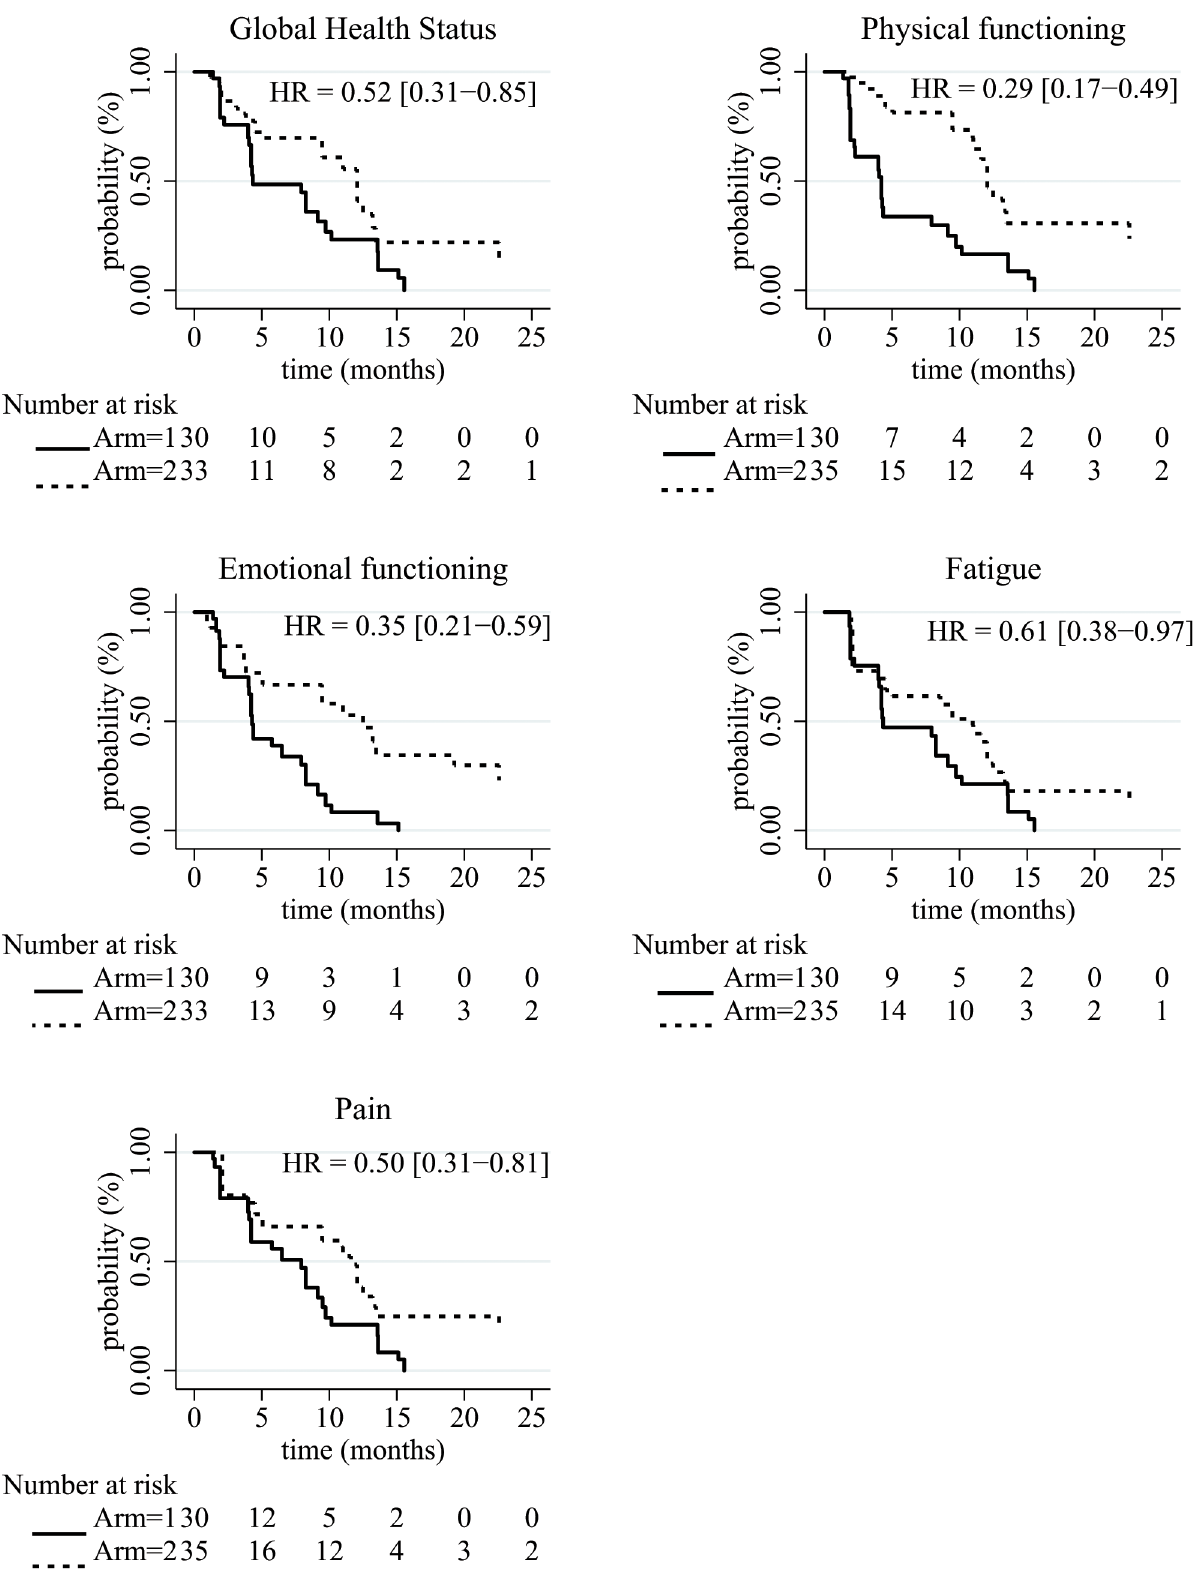
Fig 3. Kaplan-Meier survival curves of the HRQoL deterioration-free survival by treatment arm for the weighted analysis. Arm 1: gemcitabine alone, Arm 2: gemcitabine + FOLFIRI.3. doi:10.1371/journal.pone.0125350.g003 PLOS ONE | DOI:10.1371/journal.pone.0125350 May 26,